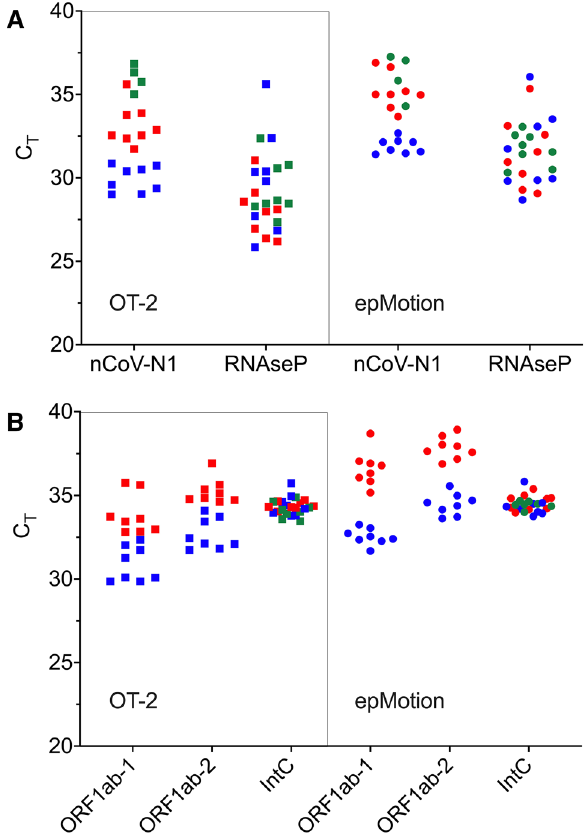
Figure 7. SARS-CoV-2 detection on hypothetical patient samples. Oropharyngeal nasal mid-turbinate samples were collected from 24 volunteers and spiked 8 each with 1 × 10 4 copies/ml (blue square, blue circle), 1 × 10 5 copies/ml (red square, red circle), heat inactivated 2019 novel coronavirus (nCoV), or water (green square, green circle). Total RNA was extracted using Opentron-2 (OT-2; squares ) and Eppendorf epMotion (epMotion; circles ). ( A ) Biological samples were analysed by SYBR one-step RT-qPCR targeting SARS-CoV-2 N gene. Artefact amplification was observed in water-spiked samples (green square, green circle). ( B ) Biological samples were analysed by multiplex, probe-based RT-qPCR targeting SARS-CoV-2 ORF1a gene.